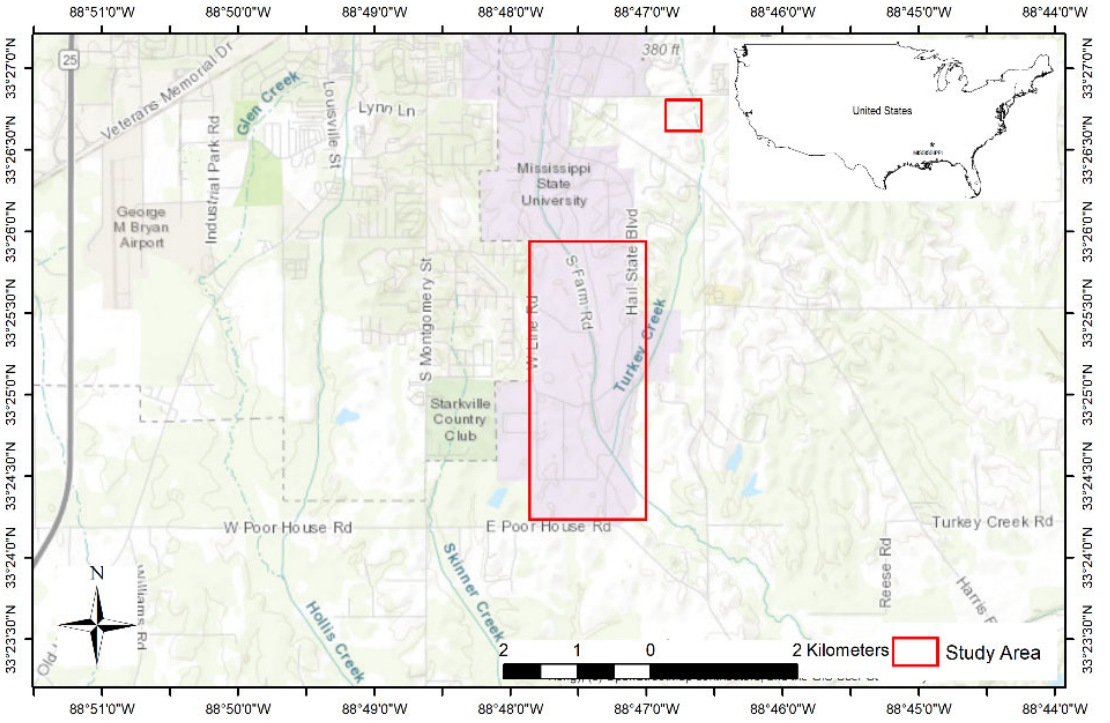
Figure 2. Study area (shown in red wire frame)—Mississippi State University properties—Cattle pastures, row crops, captive facilities, and small farm ponds.